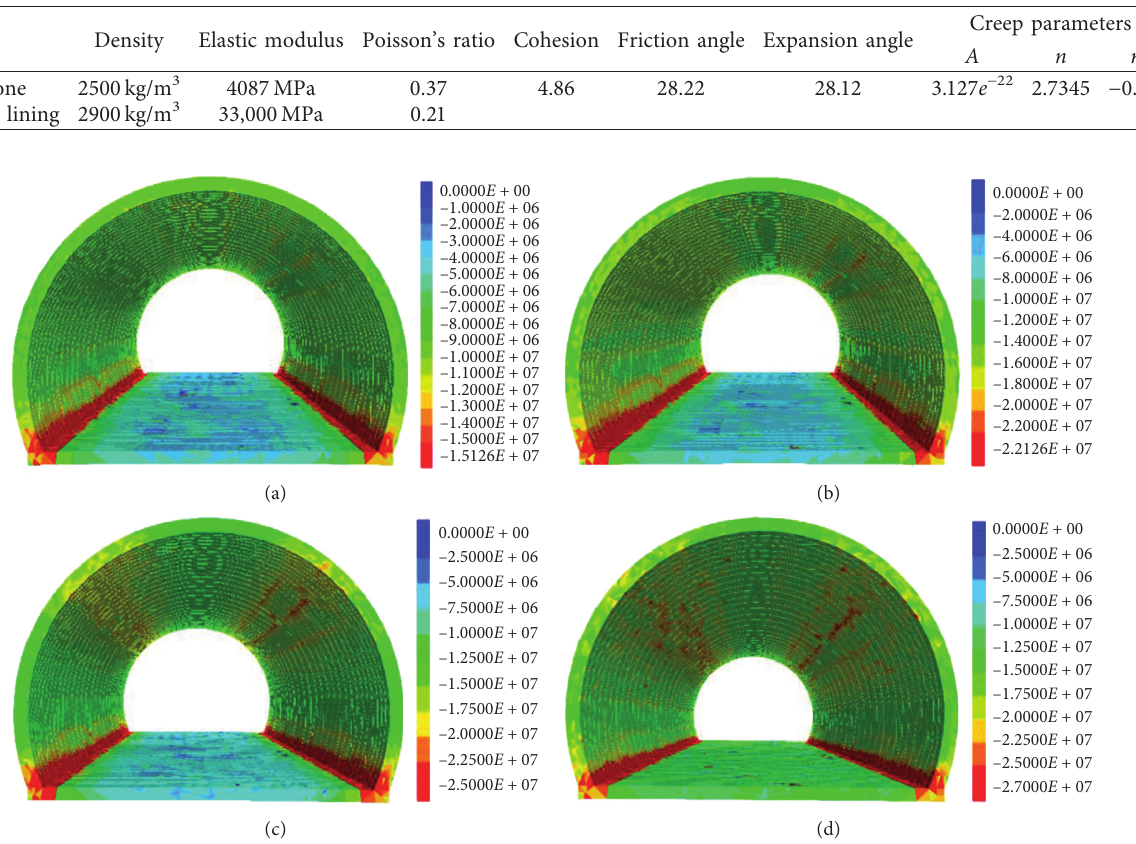
Figure 7: Numerical modeling. (a) Numerical calculation model. (b) Joint distribution model. Table 1: Rock mechanics parameters.